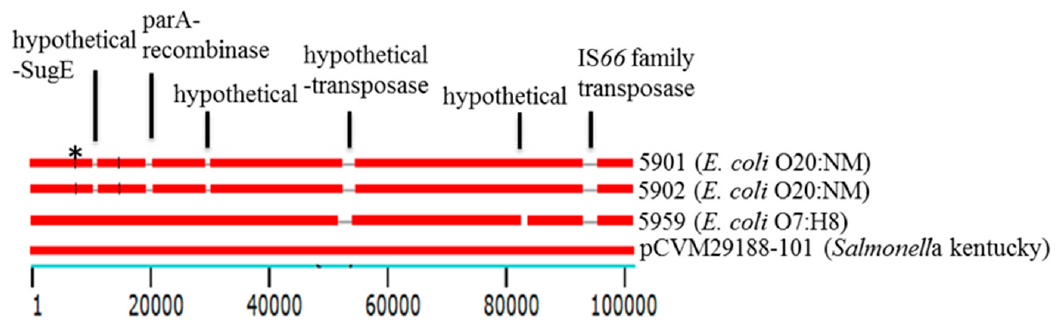
Figure 5. Nucleotide sequence alignments of bla CMY-2 containing plasmids identified in three sequenced E. coli isolates in this study to the previously characterized 101,461 bp plasmid pCVM29199-101 (GenBank accession # NC_011077) of Salmonella Kentucky isolated from poultry. The asterisk above the alignment indicates the position of class C β -lactamase bla CMY-2 present in all of the plasmids. The proteins absent in the plasmids are listed above the alignment. ParA and SugE are a chromosome partitioning and a quaternary ammonium compound-resistance protein, respectively. The E. coli isolates containing the plasmids are indicated on the